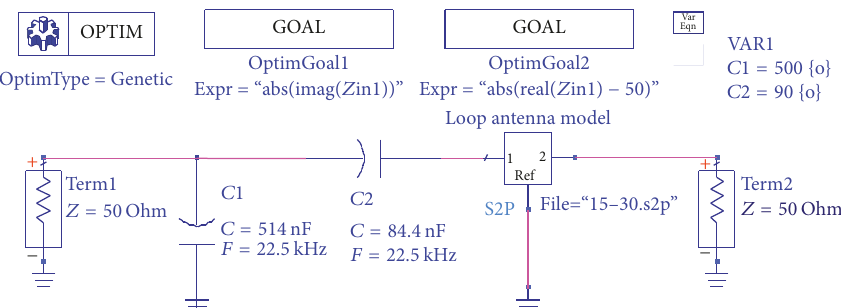
Figure 8: The designed passive matching circuit for comparison with the non-Foster matching circuit; the s2p file is the loop antenna model. Genetic algorithm in ADS was used to optimize the values of 𝐶 1 and 𝐶 2 .